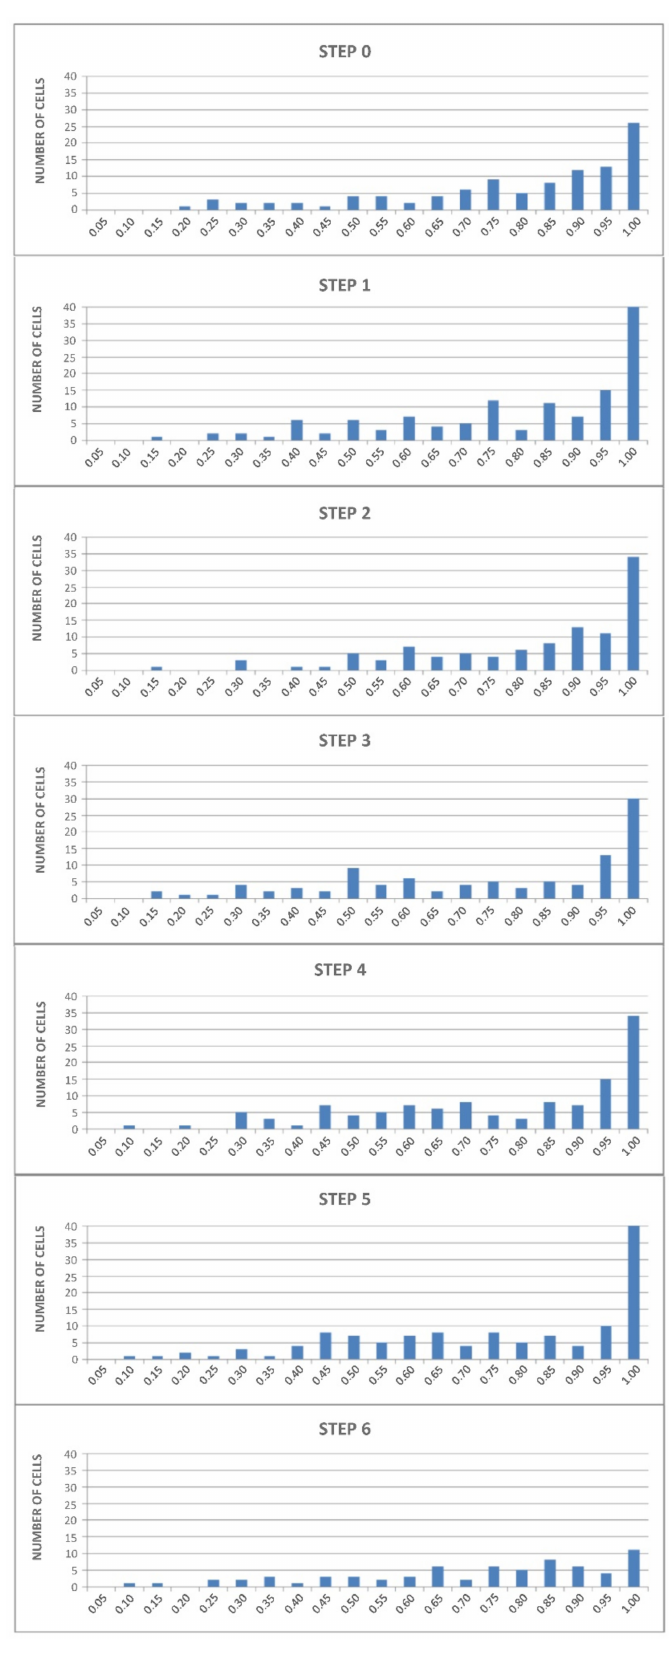
Figure 9. Distributions of the circularity C at the end of each compression step (0.4% TiH 2 foam, XZ